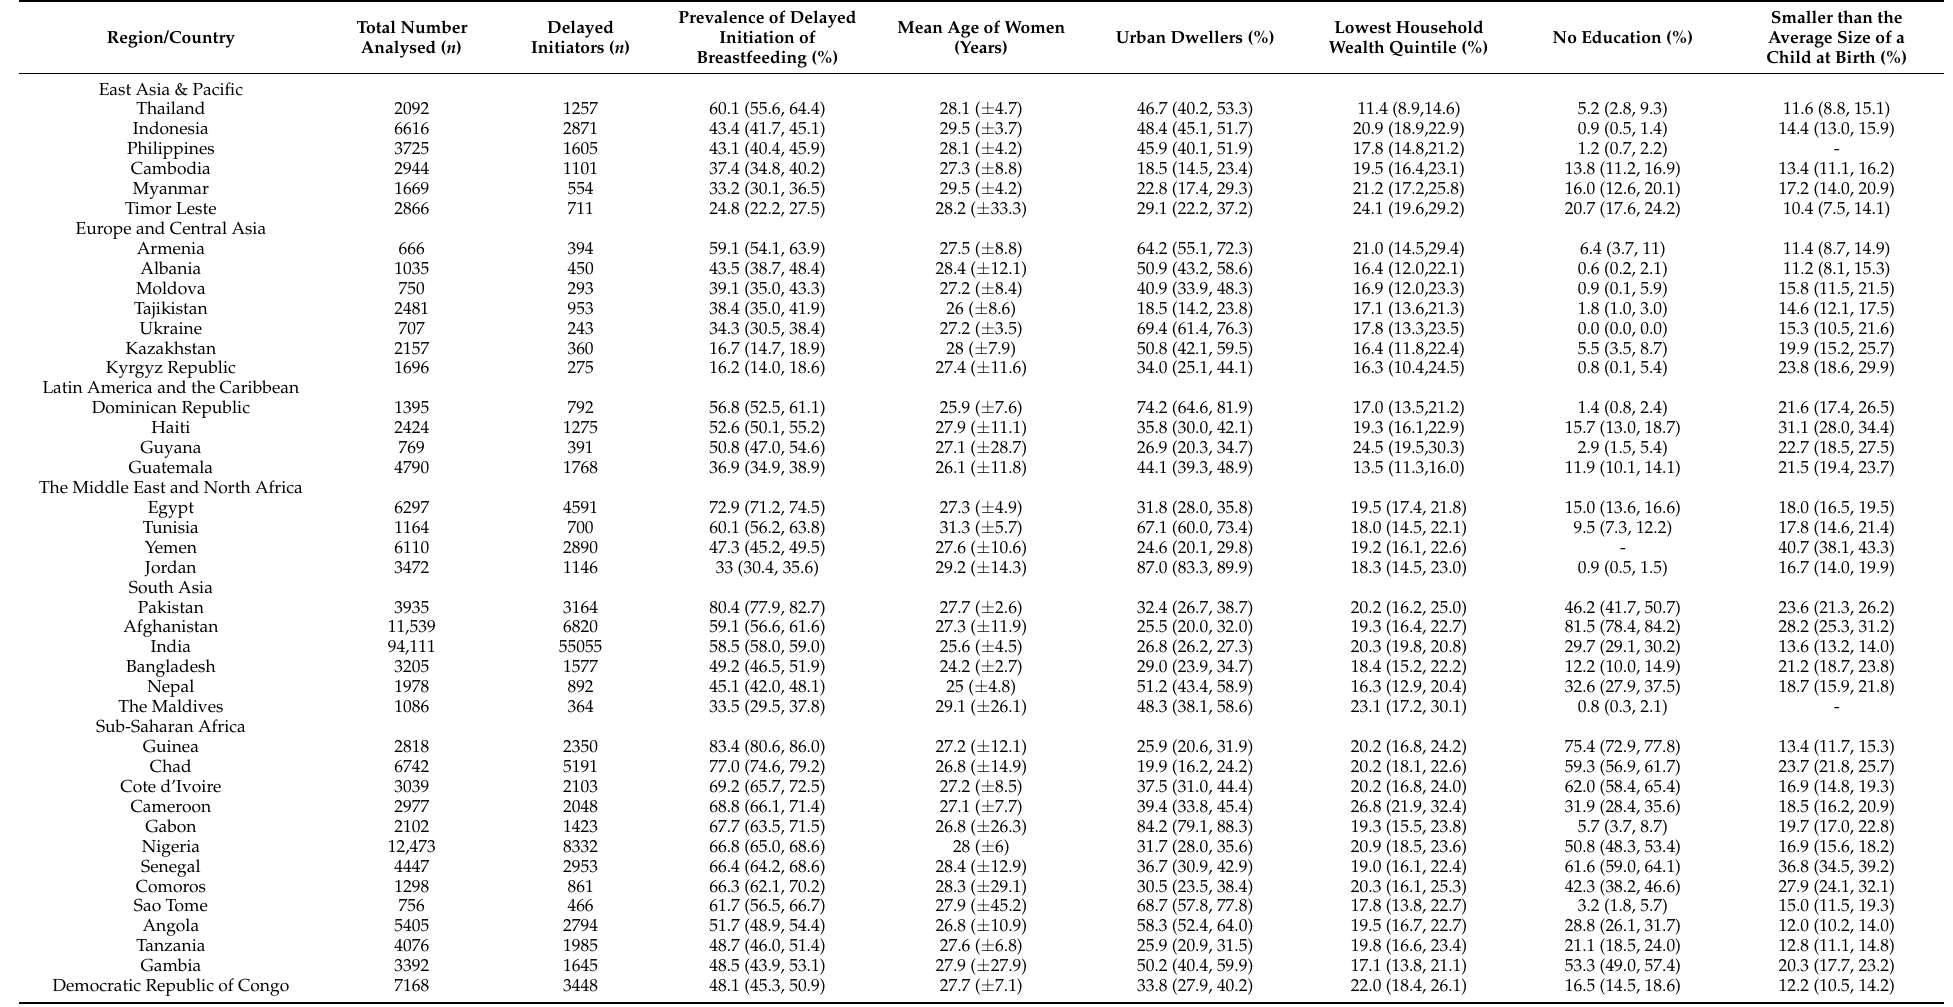
Table 1. Background characteristics among delayed initiators, i.e., women aged 15–49 years with a live-born child in the two years preceding the survey who delayed breastfeeding initiation beyond the first hour of